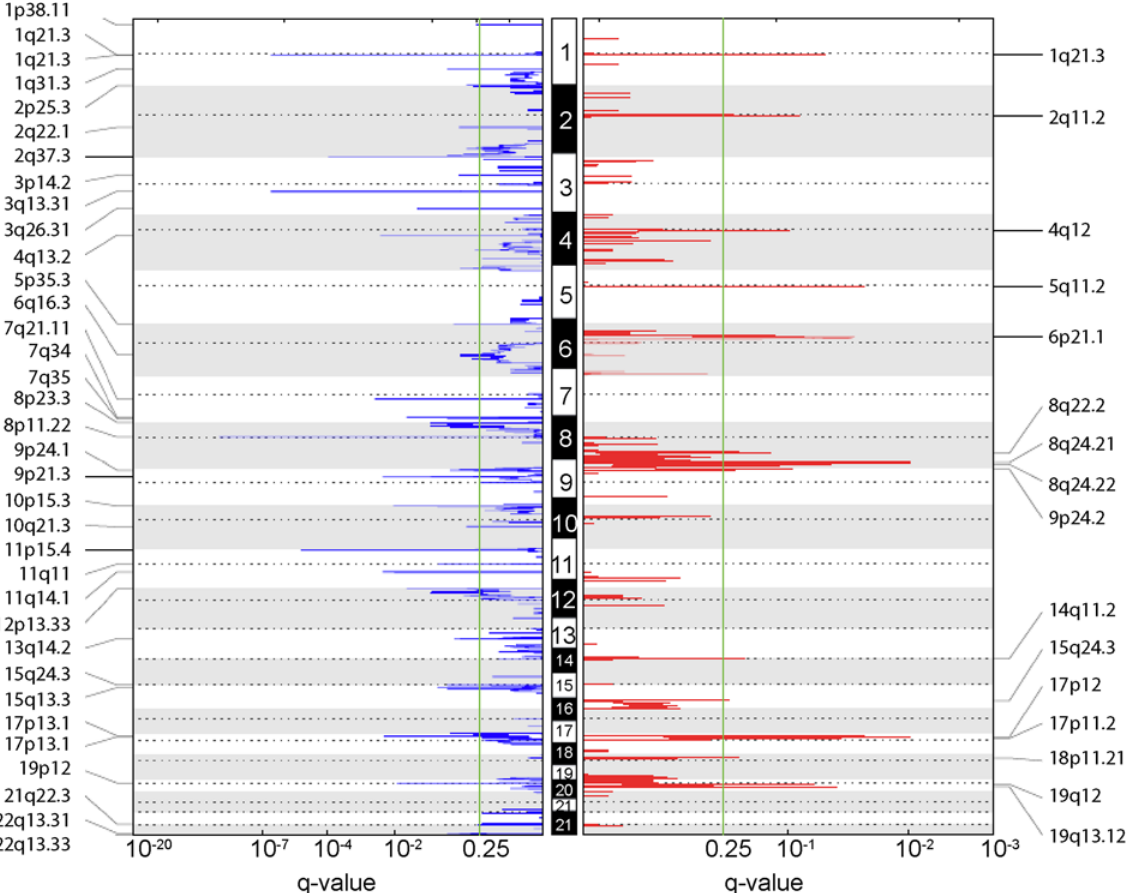
Fig 2. Significant regions of copy number variation in osteosarcoma. The plots show the q-values (x-axes) determined by GISTIC 2.0 with respect to significant lost (blue) and gained (red) genomic regions among the human chromosomes 1 to 22 (hg19). The green lines indicate the significance threshold of q-value < 0.25. The cytobands of significant aberrant regions are denoted on the